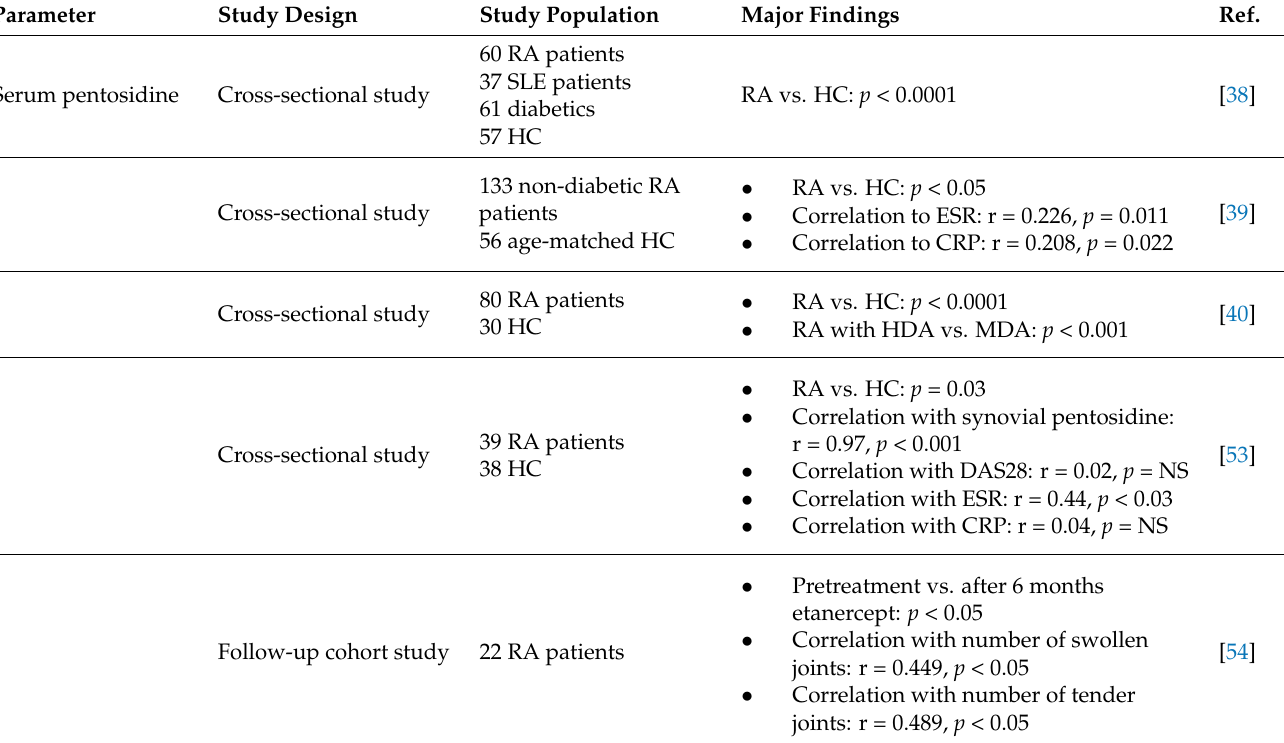
Table 1. Overview of studies investigating advanced glycation end products (AGEs) and the (soluble) receptor for AGEs ((s)RAGE) in rheumatoid